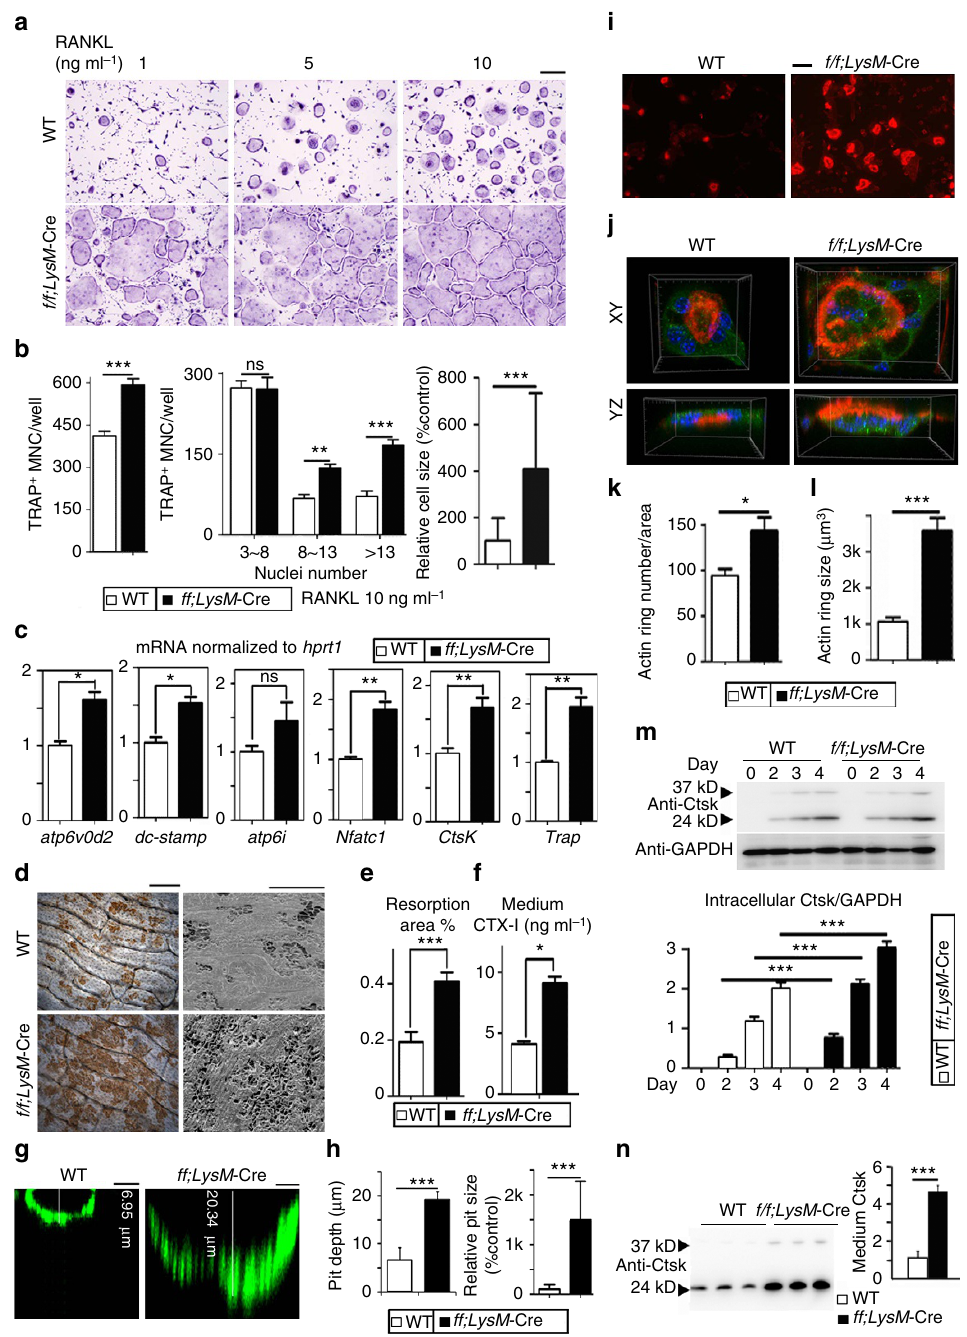
Figure 3 | Loss of G a 13 promotes osteoclast formation and function. ( a ) TRAP staining to detect osteoclast formation from WT and Gna13 f/f LysM -Cre ( f/f;LysM -Cre) BMMs treated by M-CSF and different doses of RANKL for 5 days. ( b ) Quantification of cell number and relative cell size in a , RANKL ¼ 10ngml (cid:2) 1 group; N ¼ 6. TRAP þ MNC, TRAP positive multinucleated cell. ( d ) Quantitative reverse transcription–PCR analysis of atp6v0d2 , dc-stamp , atp6i , nfatc1 , ctsk and trap expression in WT and Gna13 f/f LysM -Cre osteoclasts; N ¼ 6. ( e ) WGA (wheat germ agglutinin) staining and SEM (scanning electron microscope) analysis of bone slides to detect bone resorption pits. ( f ) Quantification of bone resorption area in e ; N ¼ 6. ( g ) Confocal microscopy of FITC-WGA stained bone resorption pits. ( h ) Quantification of bone resorption pit depth and relative pit size in g . Culture medium CTX-I (type I collagen carboxy-terminal peptide) concentration measured by ELISA. ( i ) Fluorescence microscopy of F-actin ring stain in mature osteoclasts. ( j ) Confocal microscopy of F-actin ring (red)/Ctsk (green)/nuclei (blue) staining in mature osteoclasts. ( k ) Quantification of F-actin ring number in i ; N ¼ 6. ( l ) Quantification of F-actin ring volume in j ; N ¼ 30. ( m ) Western blot to detect intracellular Ctsk protein level, and its quantification (lower panel); N ¼ 3. ( n ) Western blot to detect Ctsk concentration in the culture medium, and its quantification (right panel); N ¼ 3. Results are expressed as mean ±